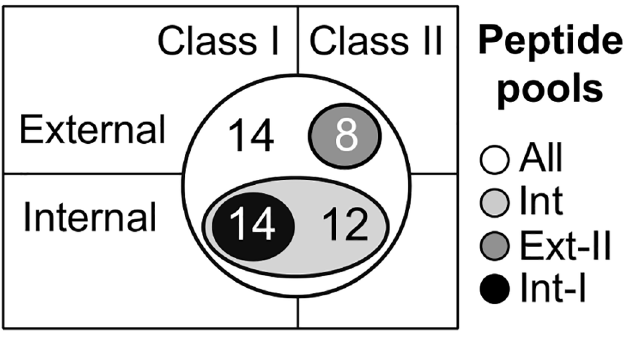
Fig 2. Peptide pools tested. All: 48 peptides. Int: 26 class I and II peptides predicted from internal proteins. Ext-II: Eight class II peptides predicted from external proteins. Int-I: 14 class I peptides predicted from internal